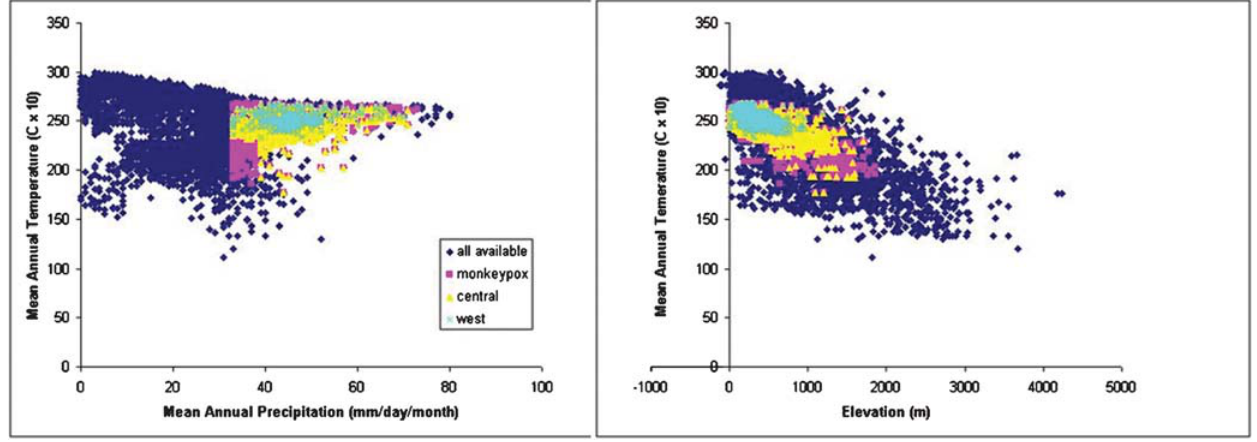
Figure 5. Visualizations of modeled monkeypox virus ecological niches in two-dimensional environmental spaces. Shown are all available habitat in the area of observation (dark blue diamonds); comprehensive monkeypox niche (pink); Central African niche (yellow), West African niche (light blue).